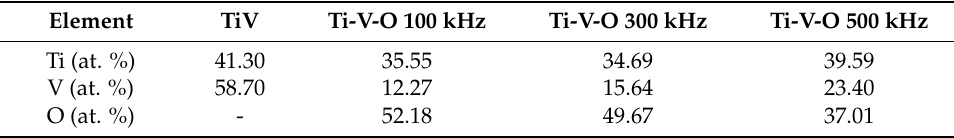
Table 2. EDS element mapping results of the TV coatings and the Ti-V-O coatings following LSTO.